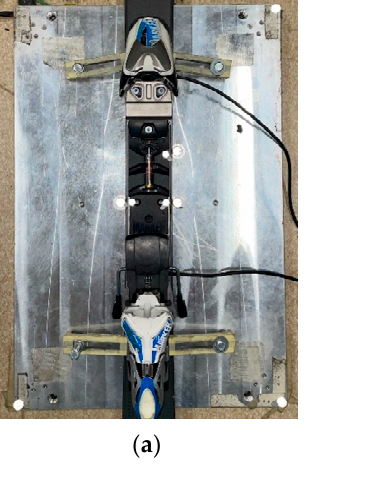
Figure 4. System validation setup: ( a ) instrumented ski mounted on the force platform, top view; ( b ) instrumented alpine ski mounted on the force platform during the test, lateral view; ( c ) ski touring boot with markers for angular sensors validation.